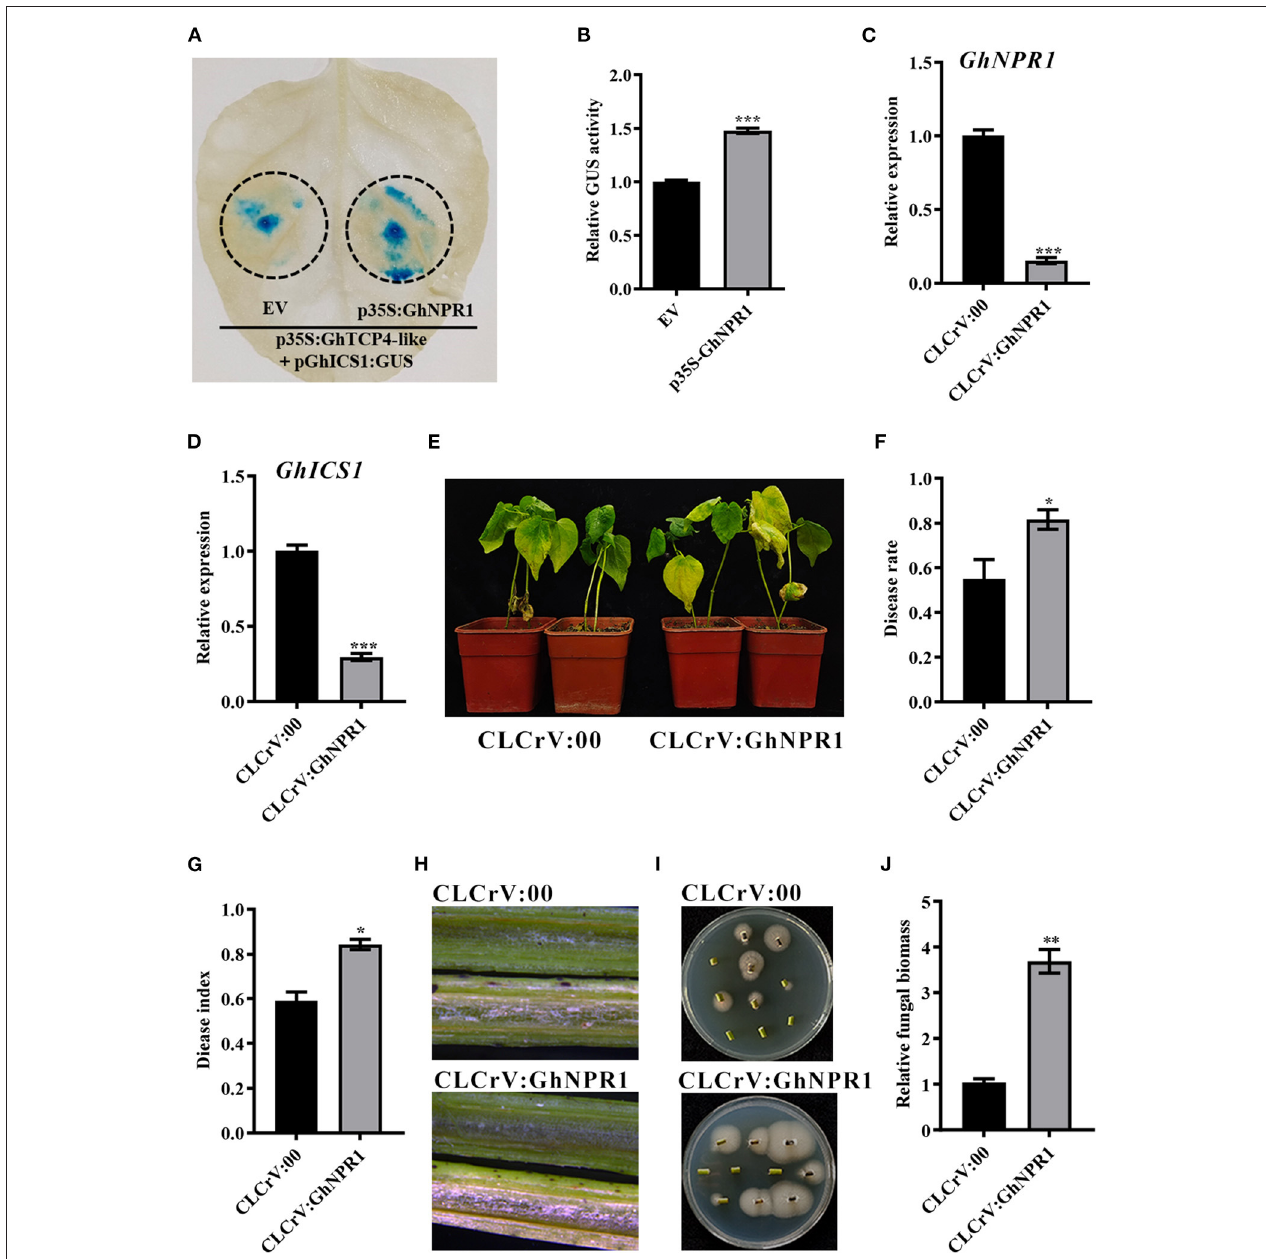
FIGURE 7 | GhNPR1 promotes transcriptional activating activity of GhTCP4-like for GhICS1 expression. (A) GUS staining assay. EV represents pCAMBIA1300. Tobacco leaves were harvested at 48h after corresponding treatments. (B) GUS enzyme activity measurement. Error bar means SD of three independent biological replications. Student’s t -test was performed, *** p < 0.001. (C) GhNPR1 expression level in CLCrV:00 and CLCrV:GhNPR1 plants. Total RNA was extracted 14 d after agroinfiltration. Error bar means SD of three independent biological replications. Student’s t -test was performed, * p < 0.05. (D) Expression of GhICS1 in CLCrV:00 and CLCrV:GhNPR1 plants 1 dpi. Error bar means SD of three independent biological replications. Student’s t -test was performed, *** p < 0.001. (E) Disease symptoms of CLCrV:00 and CLCrV:GhNPR1 plants after V. dahliae infection. Photos were taken at 21 dpi. (F,G) Disease rate and disease index of CLCrV:00 and CLCrV:GhNPR1 plants 21 dpi. Error bar means SD of three independent biological replications. Student’s t -test was performed, * p < 0.05. (H) Color intensity of longitudinal sections of the stem of CLCrV:00 and CLCrV:GhNPR1 plants 21 dpi. Photos were taken by the body microscope. (I) Fungus discovery culture assay. Stems from CLCrV:00 and CLCrV:GhNPR1 plants 21 dpi were sprayed on PDA medium. Photos were taken after 5 d of culture at 25 ◦ C. (J) Relative fungal biomass in CLCrV:00 and CLCrV:GhNPR1 plants were determined by qPCR at 21 dpi. Error bar means SD of three independent biological replications. Student’s t -test was performed, ** p <